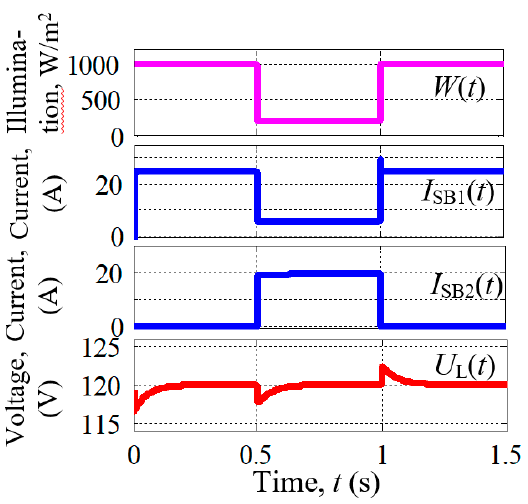
Figure 18. System response to illumination changes. W = 1000–200–1000 W/m 2 . T =25 °C.